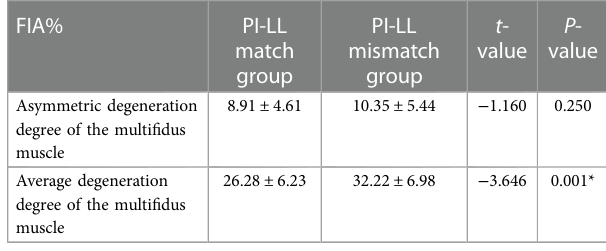
PI-LL, pelvic incidence minus the lumbar lordosis angle; FIA%, percentage of fat in fi ltration area. *Signi fi cant if P <0.05.